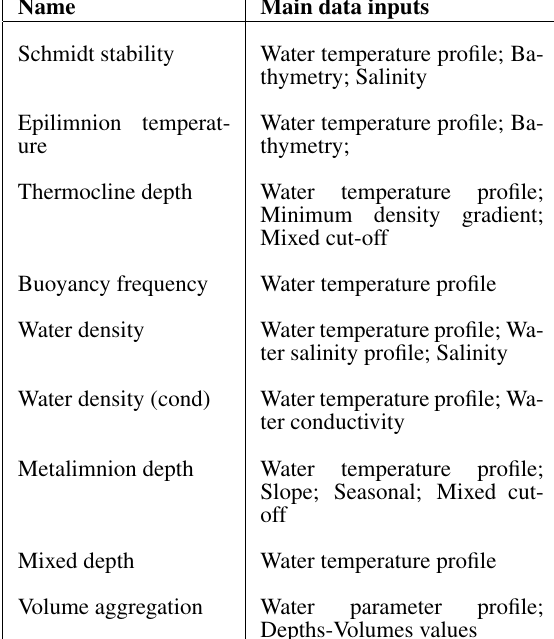
Table 1. List of functions available on the Lake Analyzer plugin.